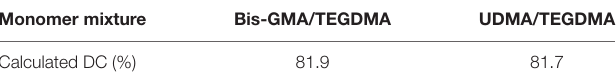
TABLE 1 | Degrees of conversion (DC) of Bis-GMA/TEGDMA and UDMA/TEGDMA specimens.